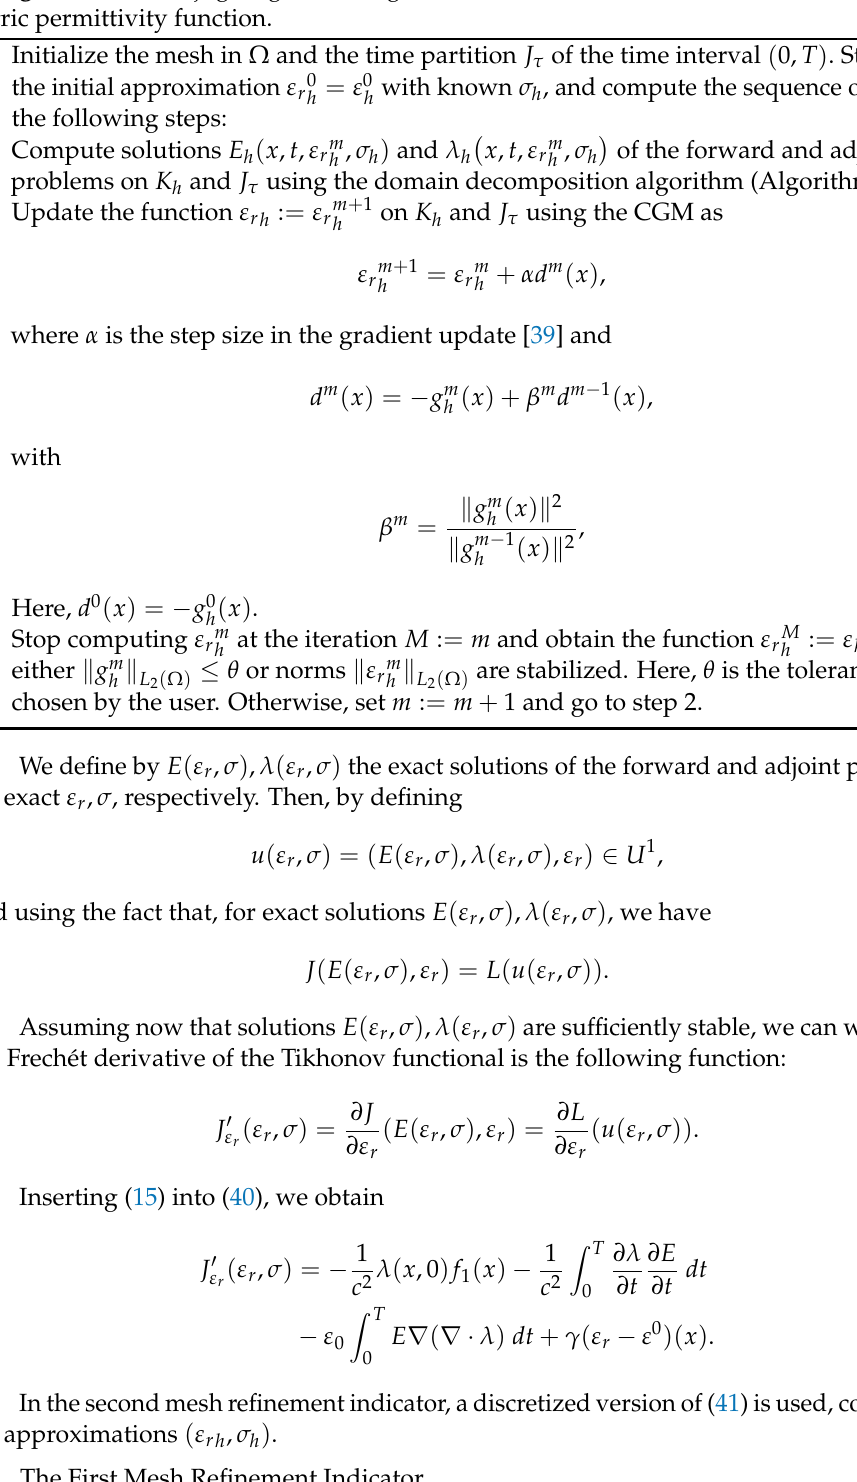
Algorithm 3: Conjugate gradient algorithm for determination of the relative dielec- tric permittivity